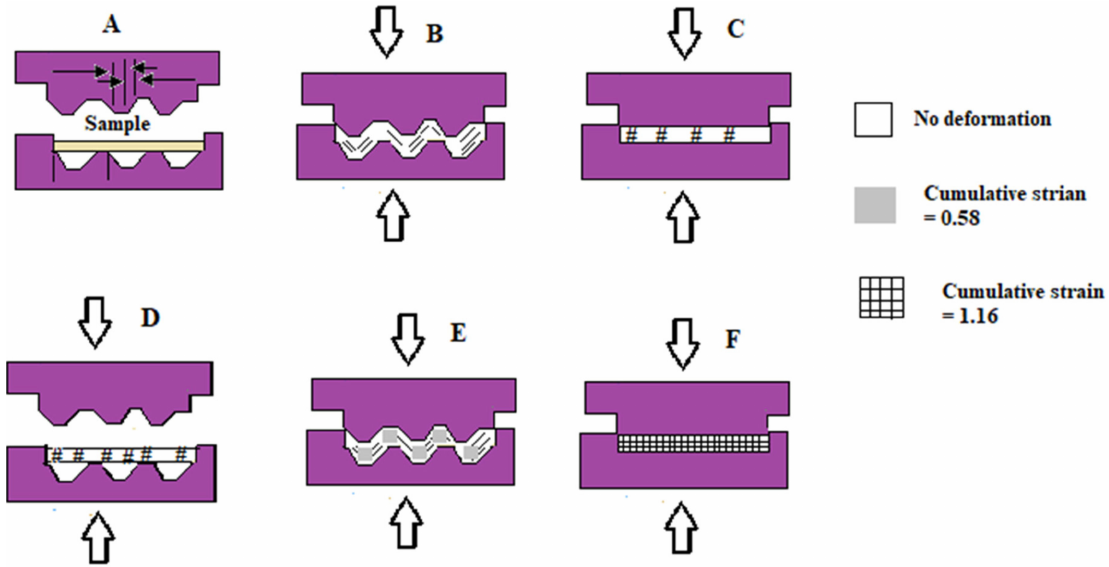
Figure 10. A schematic illustration of the sequences of the constrained groove-pressing (CGP) technique; groove pressing stage ( A , B ), sample is rotated by 180 ◦ ( D ), the successive pressings with a grooved die ( E ), a flat die ( F ), reproduced from [76,79], with permission from Elsevier,